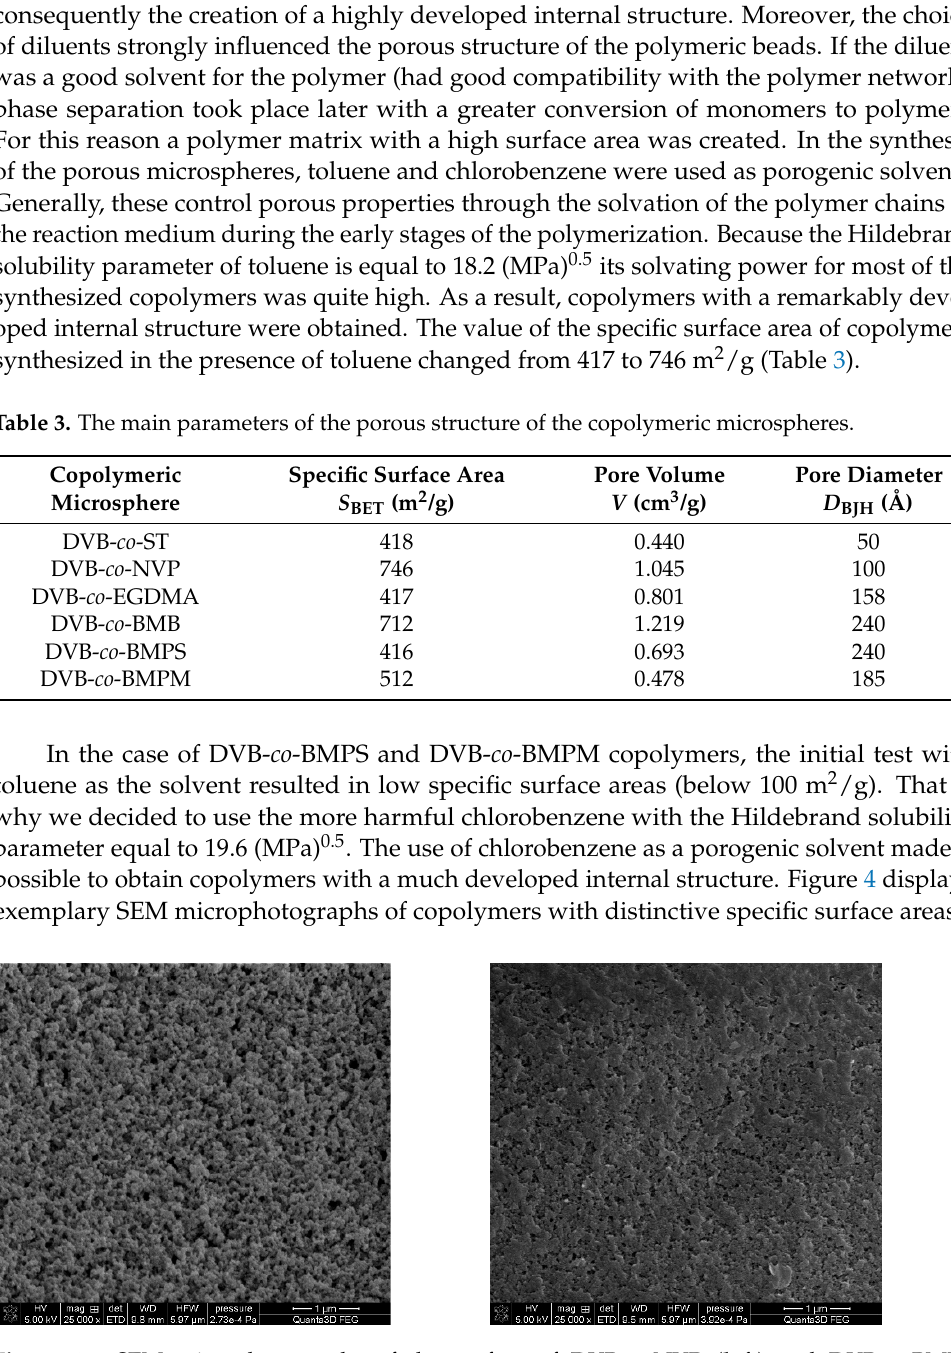
Figure 4. SEM microphotographs of the surface of DVB- co -NVP ( left ) and DVB- co -BMPS ( right ) copolymers.